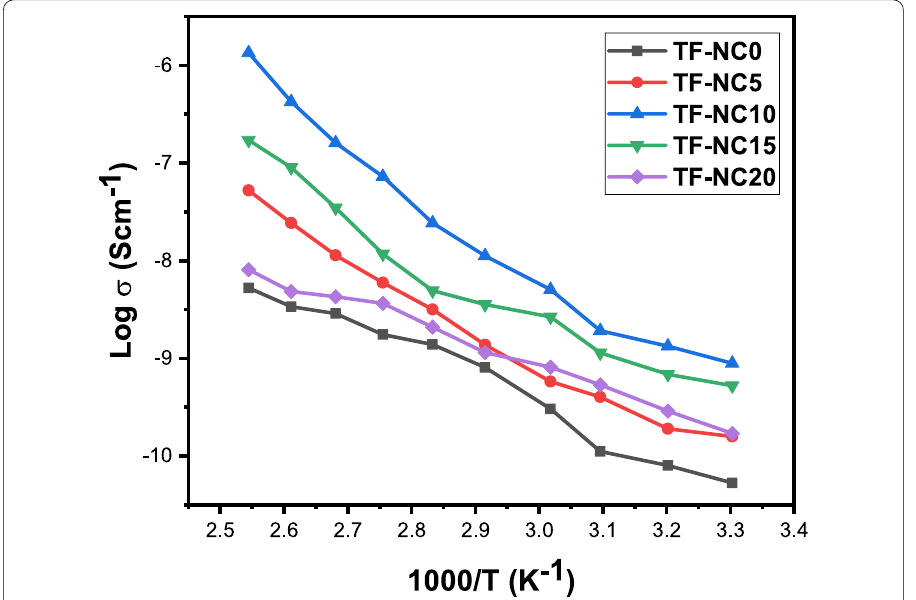
Fig. 8 Temperature dependence on ionic conductivity of a TF-NC0, b TF-NC5, c TF-NC10, d TF-NC15, and e